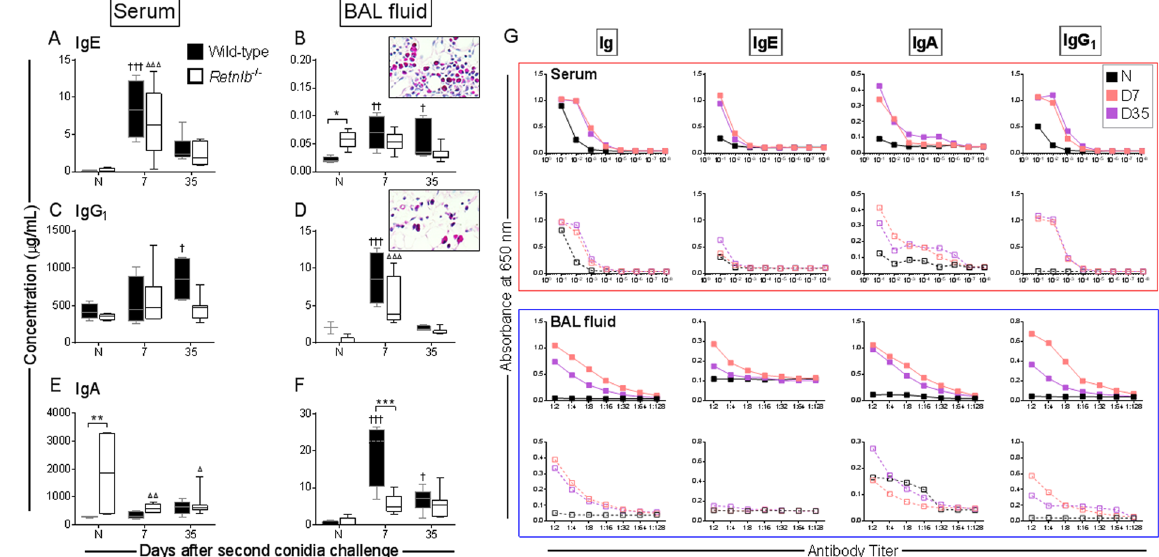
Figure 6. Systemic and local antibody responses were induced in both wild-type (WT) and Retnlb null mice (KO). Antibody levels in the serum and bronchoalveolar lavage (BAL) fluid were measured at each time point after the second fungal challenge. Allergen exposure led to an increase in immunoglobulin (Ig) E levels in the serum ( A ). IgE in the BAL fluid also increased after allergen exposure in WT mice, but did not change over baseline in the KO group which had significantly more IgE at baseline, compared to WT ( B ). Serum IgG 1 levels increased after allergen challenge but did not reach significance until the late time point in the WT mice ( C ). Changes in the mucosal IgG 1 was apparent at early time points in both groups ( D ). Steady state systemic IgA was high in the KO mice, which reduced after allergen challenge while WT IgA in the serum increased minimally over naïve controls ( E ). IgA levels in the BAL fluid increased in response to allergen provocation in the WT and this increase was delayed in the KO, but did not reach statistical significance ( F ). More Mott cells (magenta coloured) were noted in the WT lungs (inset B ) than in KO (inset D ). Aspergillus fumigatus -specific antibodies were produced in both groups but generally more abundant in the WT mice compared to KO ( G ). Data are represented as the mean and SD of n = 4–7 mice/group in one representative study of two independent studies. Data shown as range from minimum to maximum where lines and dots represent the median and mean respectively. Data analysed with two-way ANOVA with Sidak’s and Dunnett’s multiple comparisons test to compare data between groups at each time point ( * ) or to naïve controls within groups († in WT and Δ in KO) respectively where significance values p < 0.05, p < 0.01, and p < 0.001 are denoted by one, two, or three symbols respectively. N – Naïve; D –